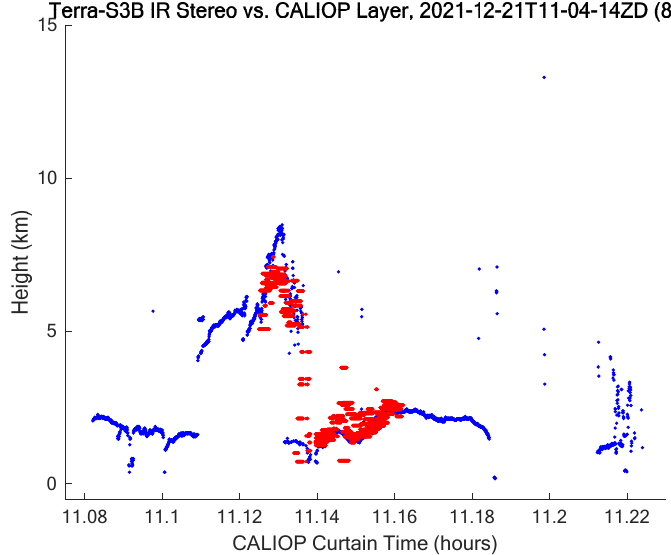
Figure 11. Collocated CALIOP and stereo winds for a single Antarctic overpass on 21 December 2021. CALIPSO follows Terra by 8 min in this case. The non-simultaneity between CALIPSO and Terra will change on each orbit due to their di ff ering orbital periods.